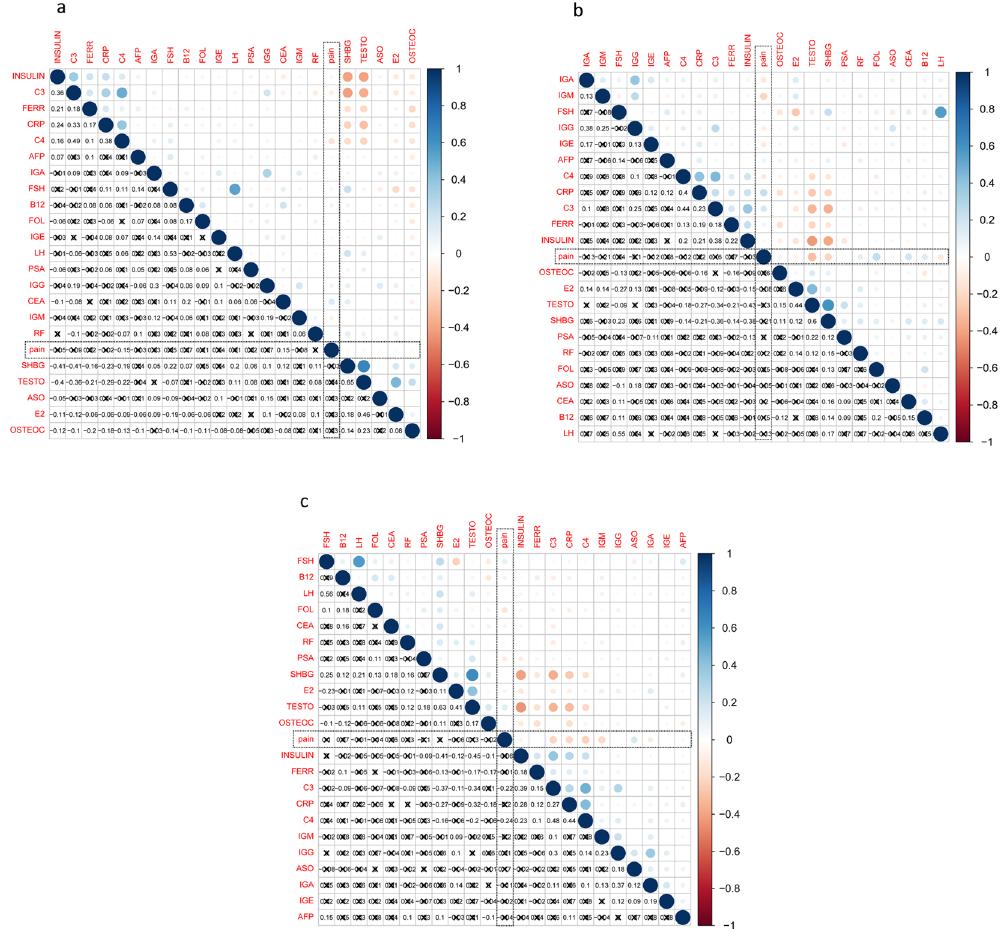
Figure 1. Correlation analysis between pain and 22 biochemical markers with Pearson. * ( a ) CPPS vs Non- CPPS; ( b ) IIIa vs Normal; ( c ) IIIb vs Normal. * The Pearson coefficients were shown in the left lower triangle. * Cross symbols indicated the associations were